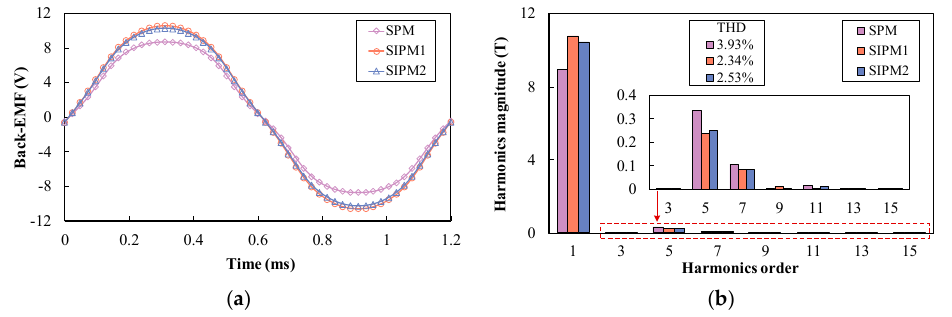
Figure 9. No-load EMF. ( a ) Waveforms. ( b ) Harmonics order.